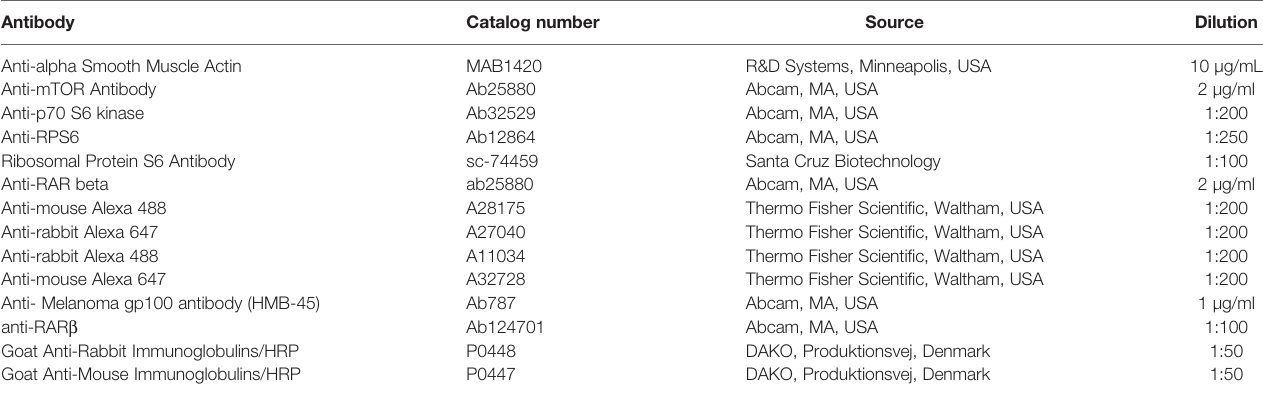
TABLE 1 | Antibodies used in western blot, immuno fl uorescent staining, and